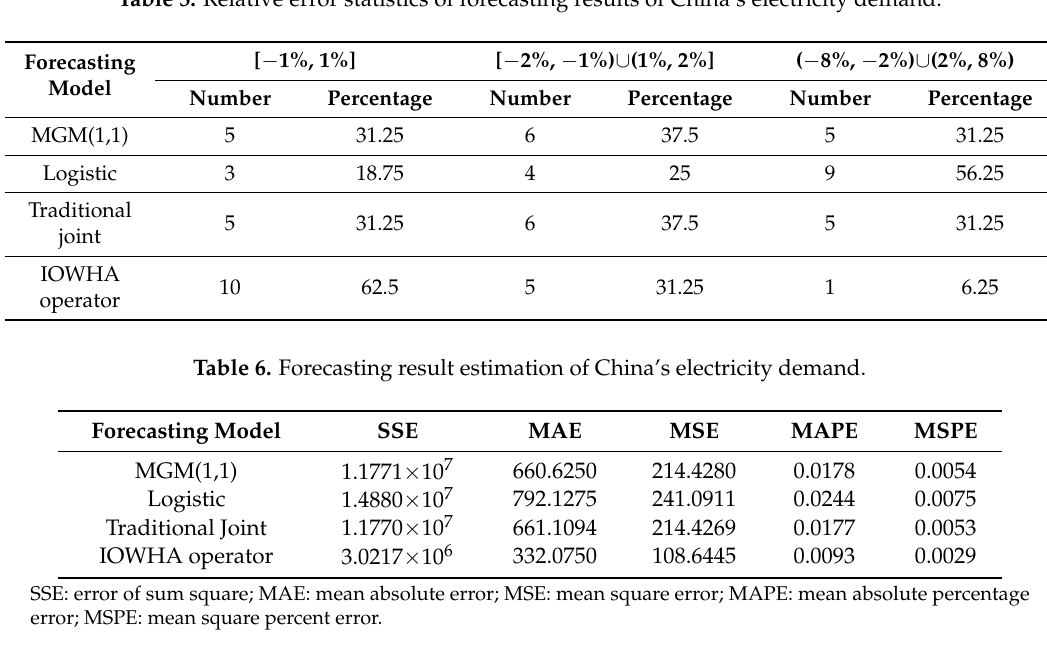
Figure 5. Relative error of forecasting results of China’s electricity demand. Table 5. Relative error statistics of forecasting results of China’s electricity demand.